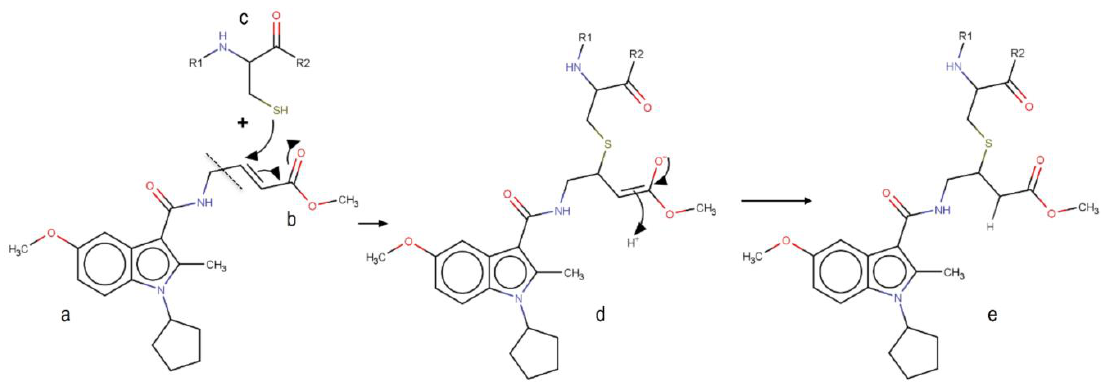
Figure 1. Mechanism of the covalent binding to the allosteric cysteine of Nedd4-1. a Non-covalent binding part of the inhibitor. b Covalent warhead of the inhibitor ( α , β -unsaturated ester). c Allosteric cysteine (Cys 627 ) of the Nedd4-1. d Intermediate product of the reaction. e Product of the reaction.